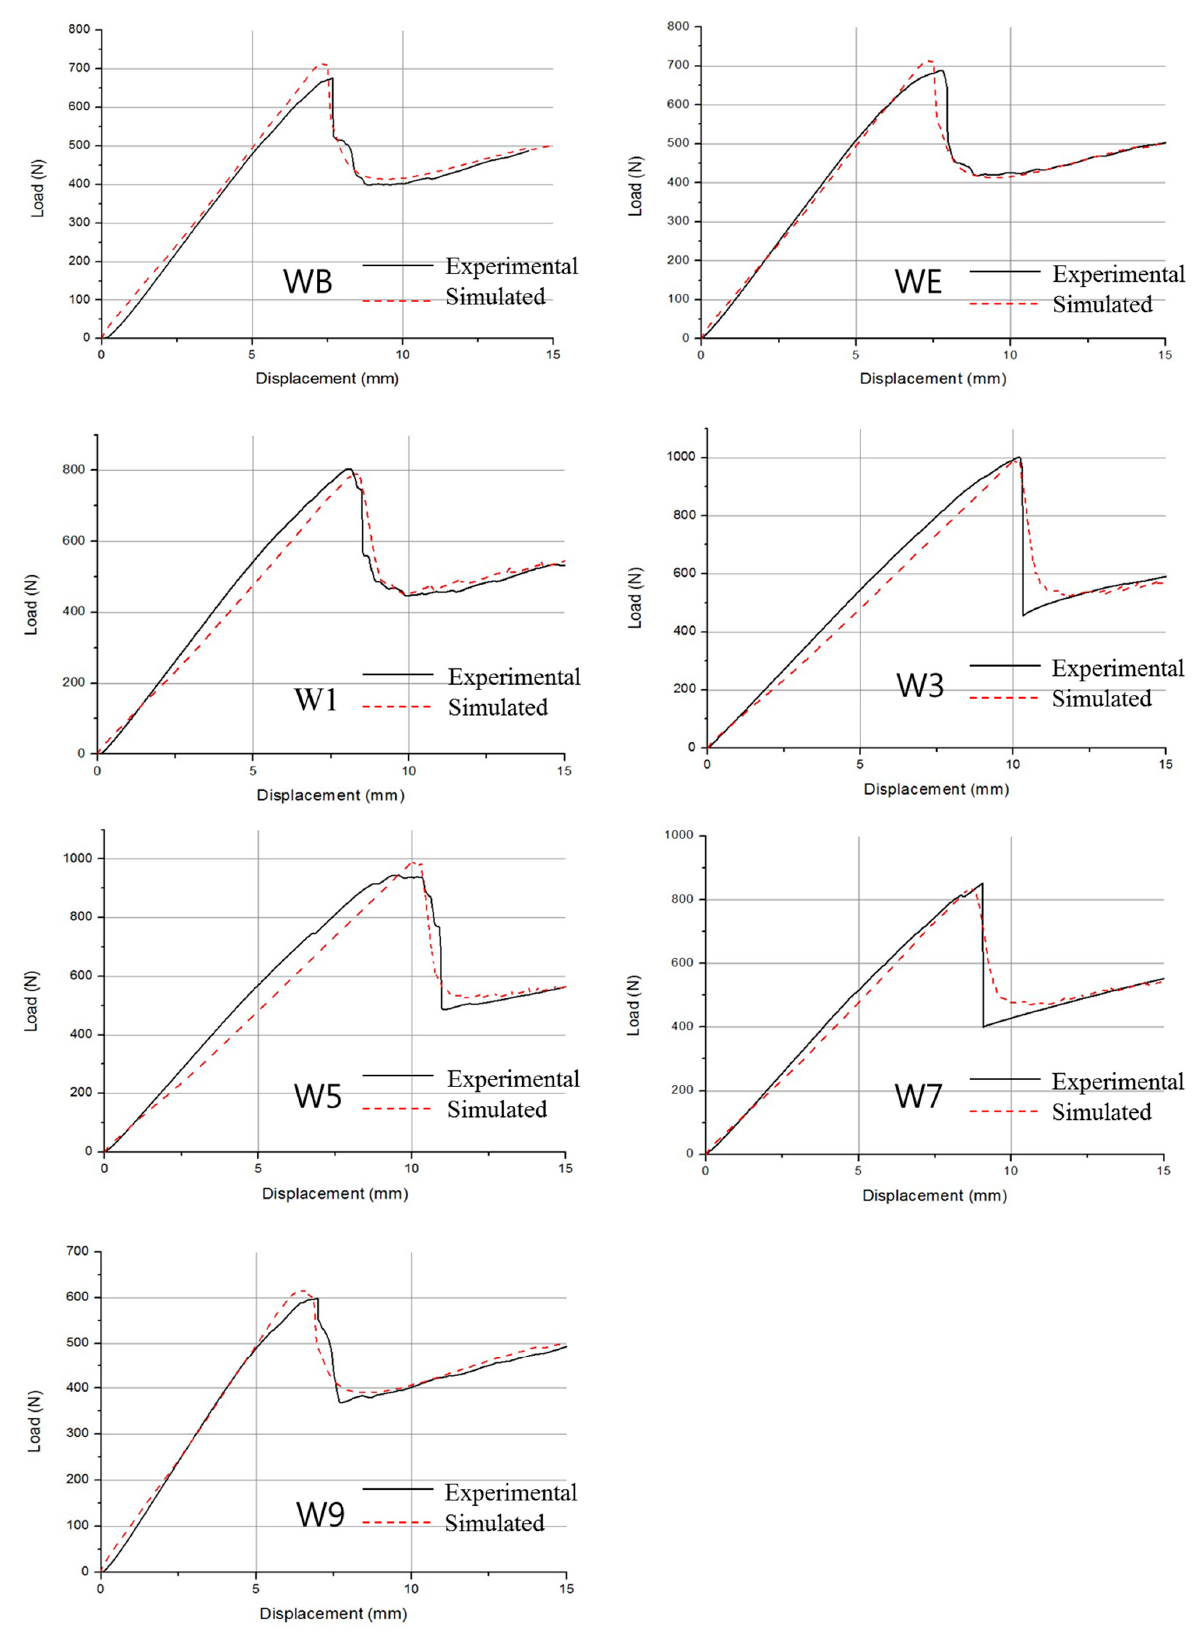
Figure 6. Experimental and simulation results with divided cohesive zone (WN).